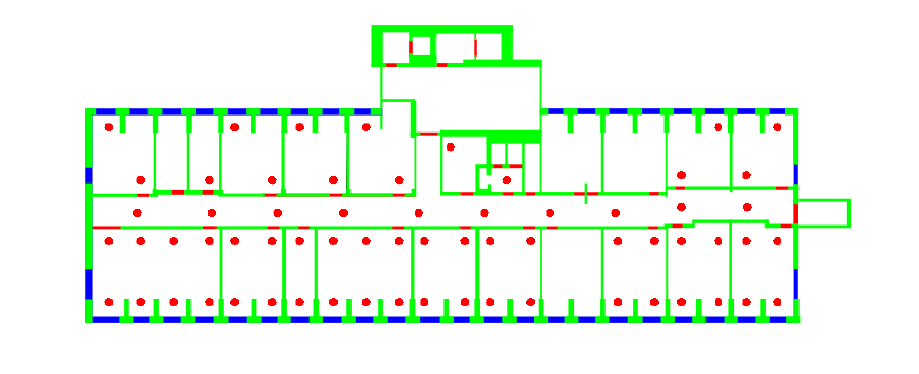
Positions of the N RPs on the Department of Information Engineering, 1 Electronics and Telecommunications (DIET) first